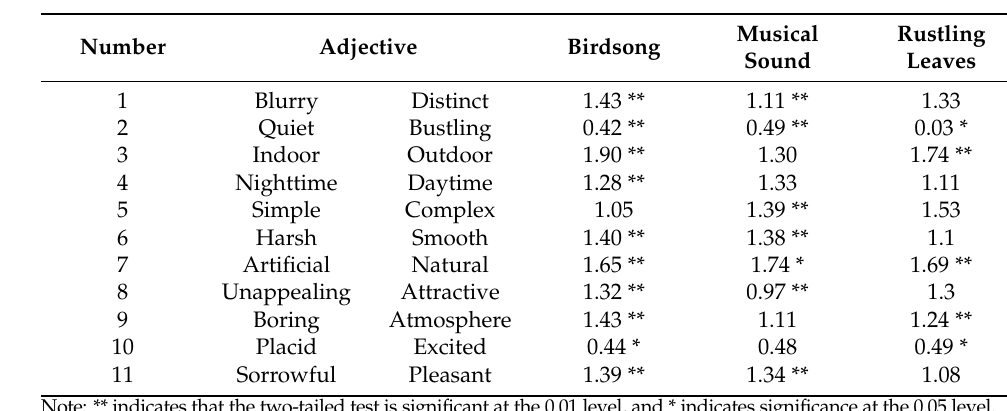
Table 6. SD scores for different types of sounds.